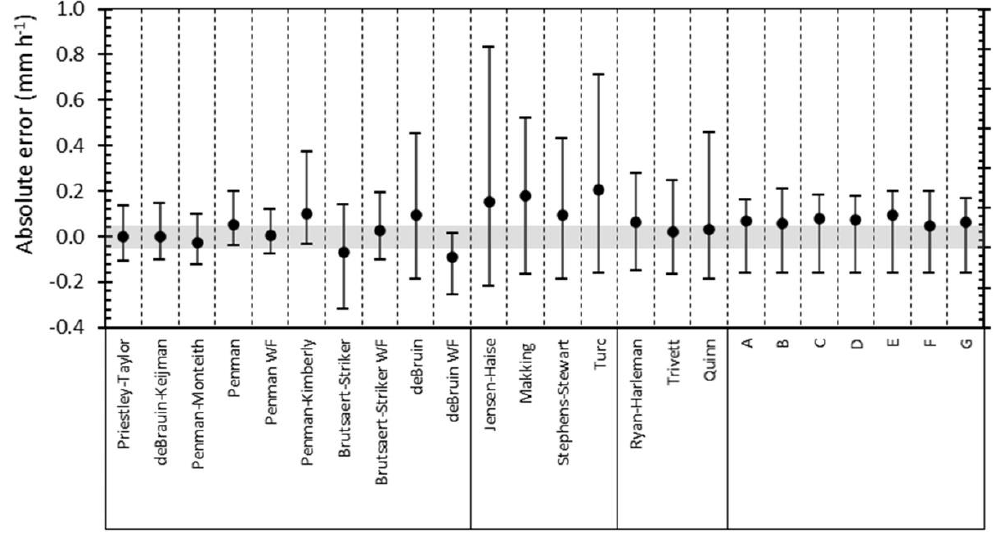
Figure 15. Maximum, minimum and average absolute errors between modeled and observed values for hourly models.